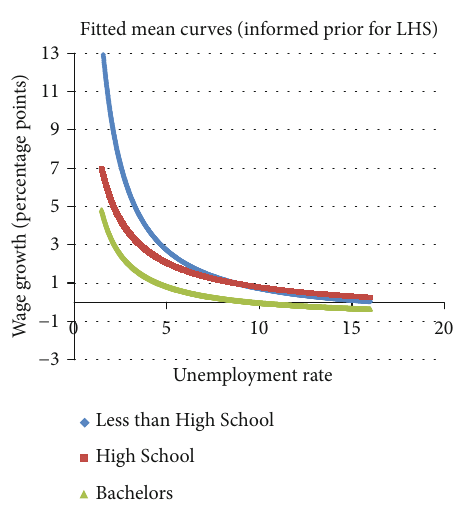
Figure 10: Fitted mean curves (informed prior for